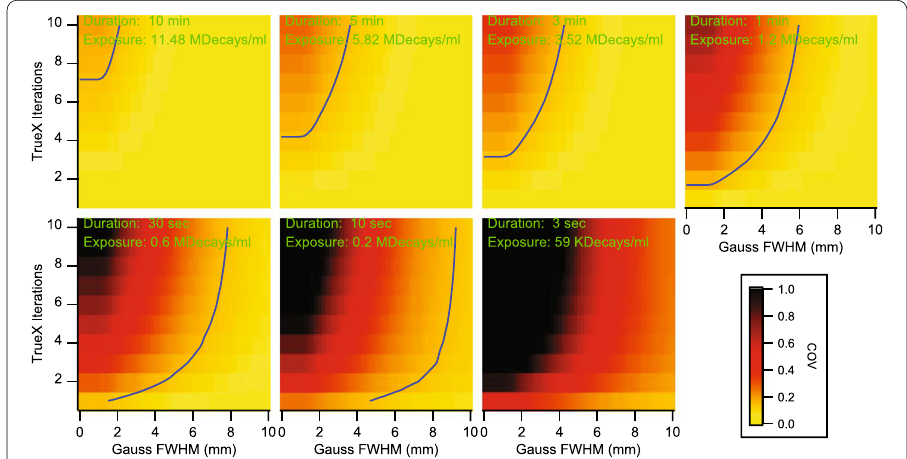
Fig. 1 Image background COV in reconstruction parameter space and for different exposures with EARL1 COV cut‑off values at 0.15 (blue